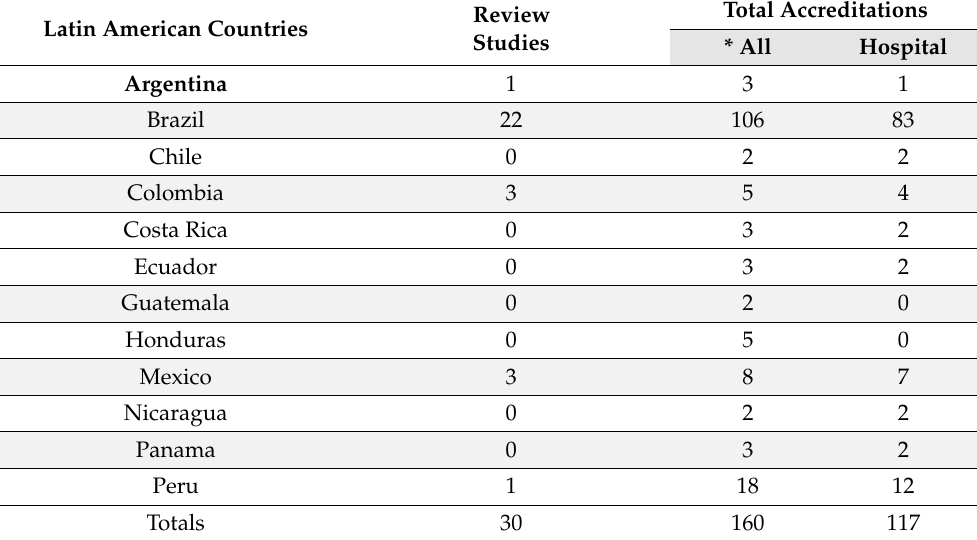
Table 3. International accreditation and HSOPSC 1.0 studies (N = 30) by country. Latin American Countries